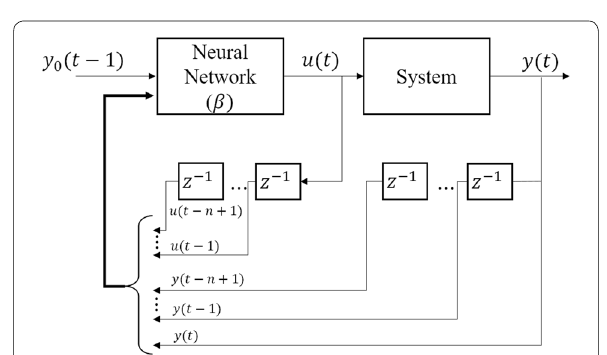
Fig. 6 Output‑based neuro controller.